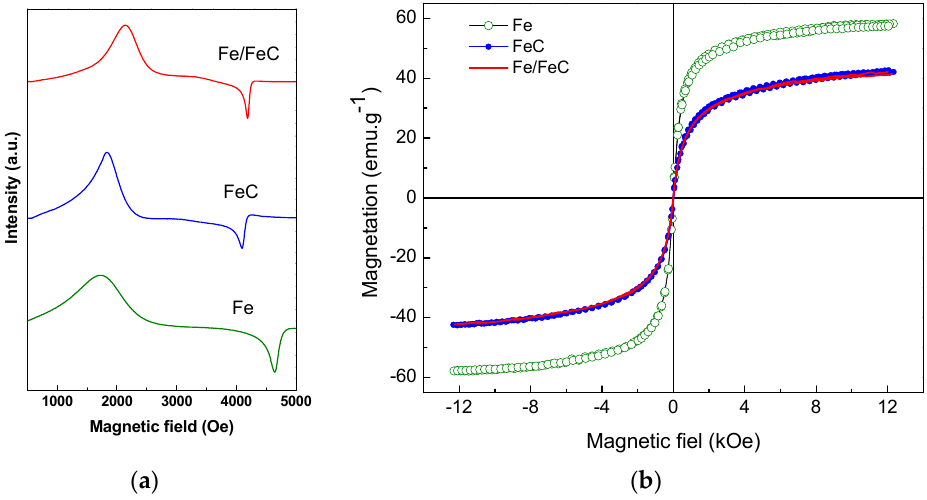
Figure 6. ( a ) EPR spectra and ( b ) Magnetic saturation hysteresis loops of the samples studied.